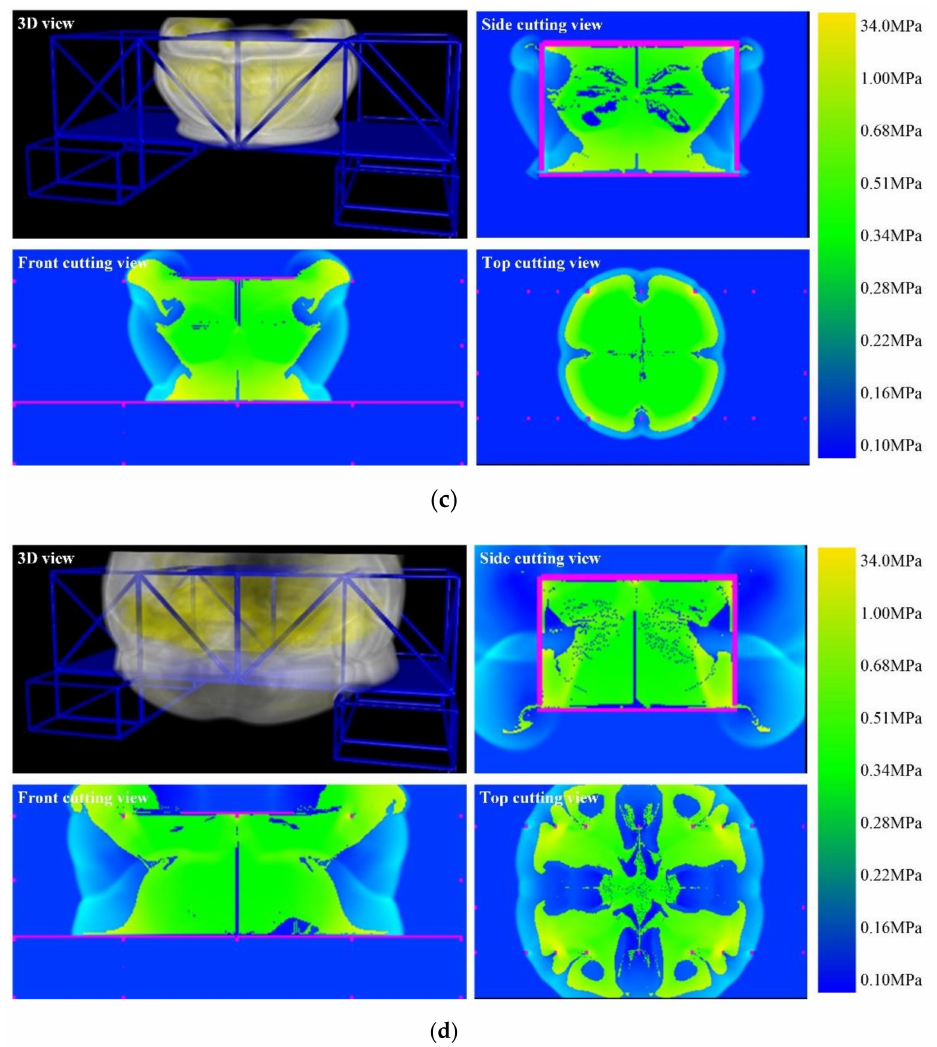
Figure 10. Explosion shock wave propagation images at different times with a certain explosion height. ( a ) t = 0.20 ms; ( b ) t = 1.80 ms; ( c ) t = 4.0 ms; ( d ) t = 8.0 ms. The gauge points used to monitor the pressure value are shown in Figure 11. The peak pressure changes with the distance from the explosion center are reflected by the comparison of the peak pressures at different gauge points. The red dot C1 represents the cylinder of 3.5 kg explosive B, the numbers 1–8, and the other rows 10–18 represent the total 17 gauge points, and each gauge point distance in the same row is 25.0 cm.